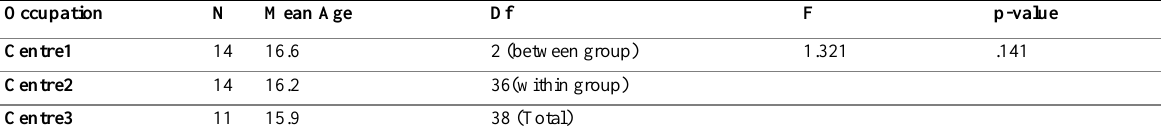
Table 5: ANOVA of the Mean Age of Children in the Three Centres